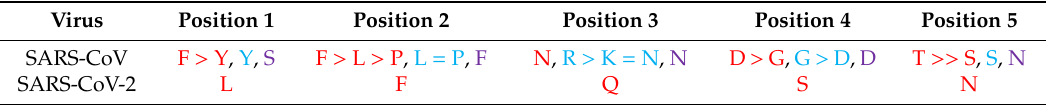
Table 2. The variants of RBM at five critical positions in SARS-CoV (442, 472, 479, 480 and 487). Virus Position 1 Position 2 Position 3 Position 4 Position 5 SARS-CoV F > Y, Y, S SARS-CoV-2 L F Q S N